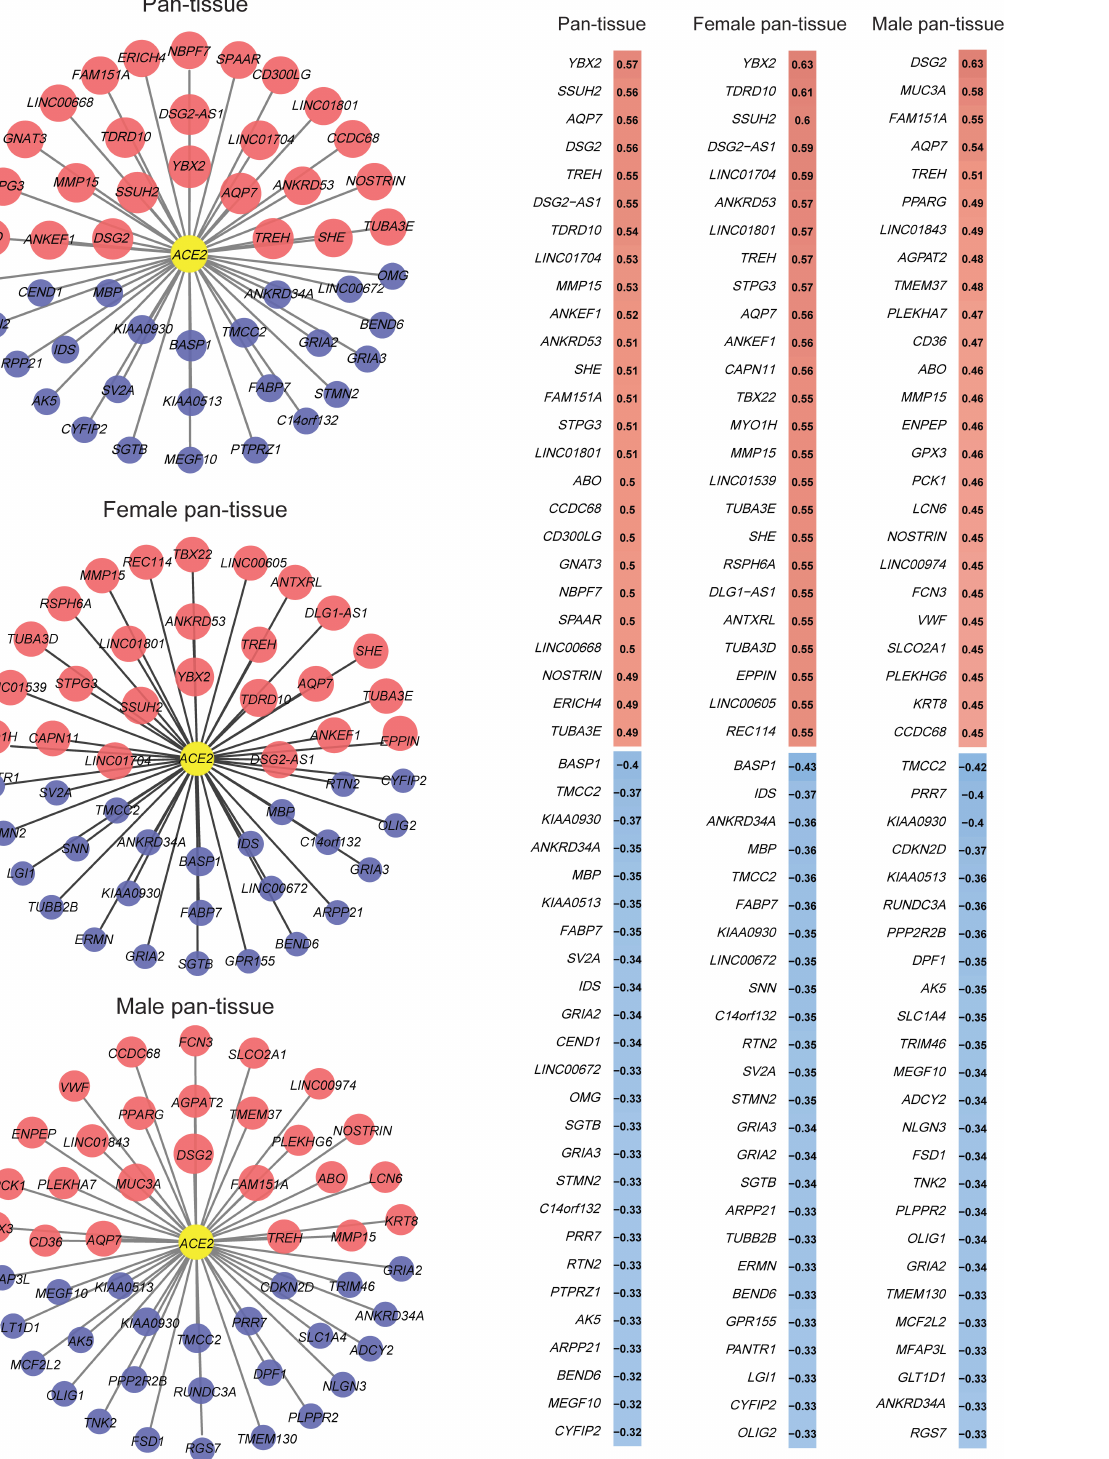
Frontiers in Molecular Biosciences |